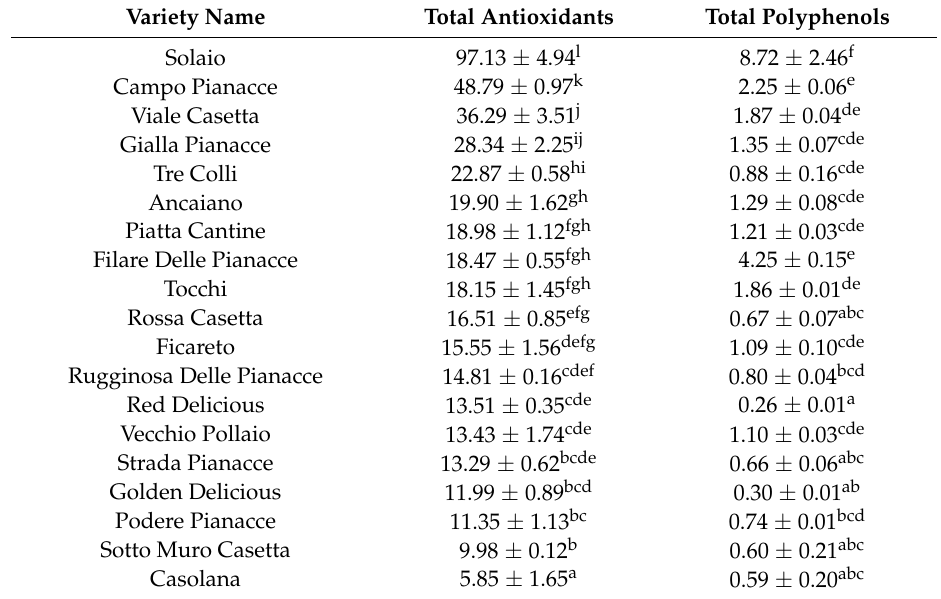
letters indicate statistically significant differences among values ( p <